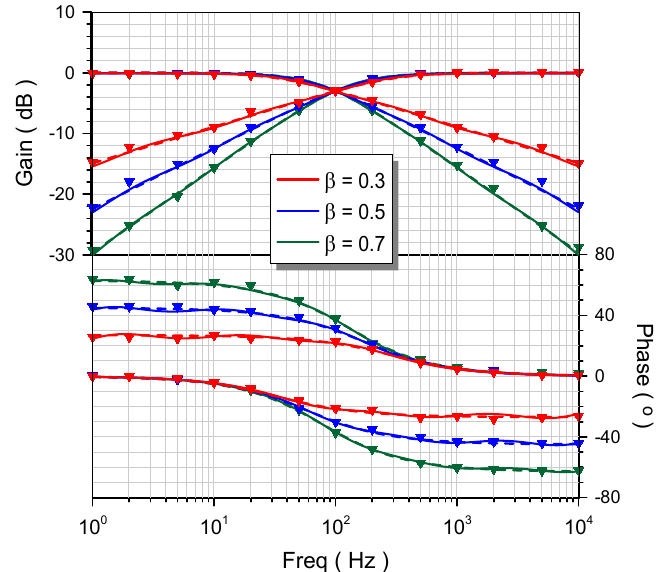
Figure 5. Experimental gain and phase frequency responses (triangle symbols), along with the corresponding approximate (solid lines) and ideal (dashed lines) responses for LP and HP filters of order β = { 0.3,0.5,0.7 }